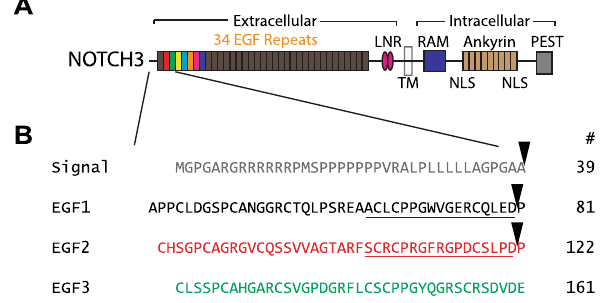
Figure 1. Domain structure and primary amino acid sequence of the N-terminus of NOTCH3. ( A ) Schematic representation of NOTCH3 protein showing N-terminal series of 34 EGF-like domains that compose the bulk of the ectodomain. The vast majority of mutations that cause CADASIL are in the N-terminal repeats that are shown in multiple colors. ( B ) The primary sequence of the N-terminus of NOTCH3 that includes the signal peptide and first three EGF-like repeats. The junction between the first (black) and second (red) and between the second and third (green) EGF-like domains contain Asp-Pro sequences (residues 80–81 and 121–122). Potential cleavage sites are designated by inverted triangles; the right column displays the amino acid position of the terminal residue of each line. The sequence terminating with Asp80 has been shown before to be cleaved 7 . The sequence underlined in black (referred to as the E1 peptide later) was previously used to generate UMI-D and UMI-F antibodies. The neo-epitope generated by the predicted cleavage after Asp121 at the end of the second EGF-like domain is underlined in red (called the E2 peptide later). A peptide corresponding to this neo- epitope was used to generate antibodies 83G, 120B, and